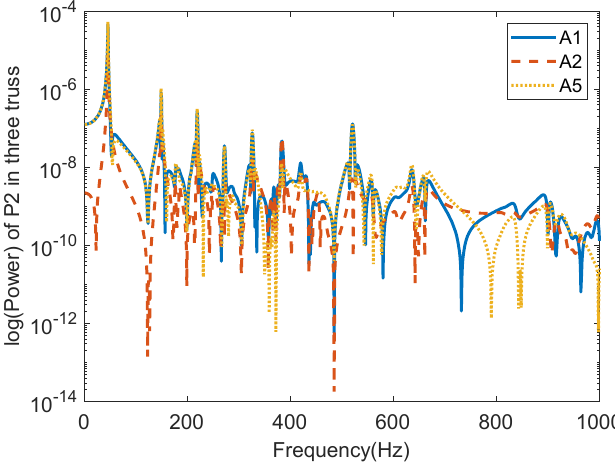
Figure 10. Vibration power flow of P2 in the Z direction.